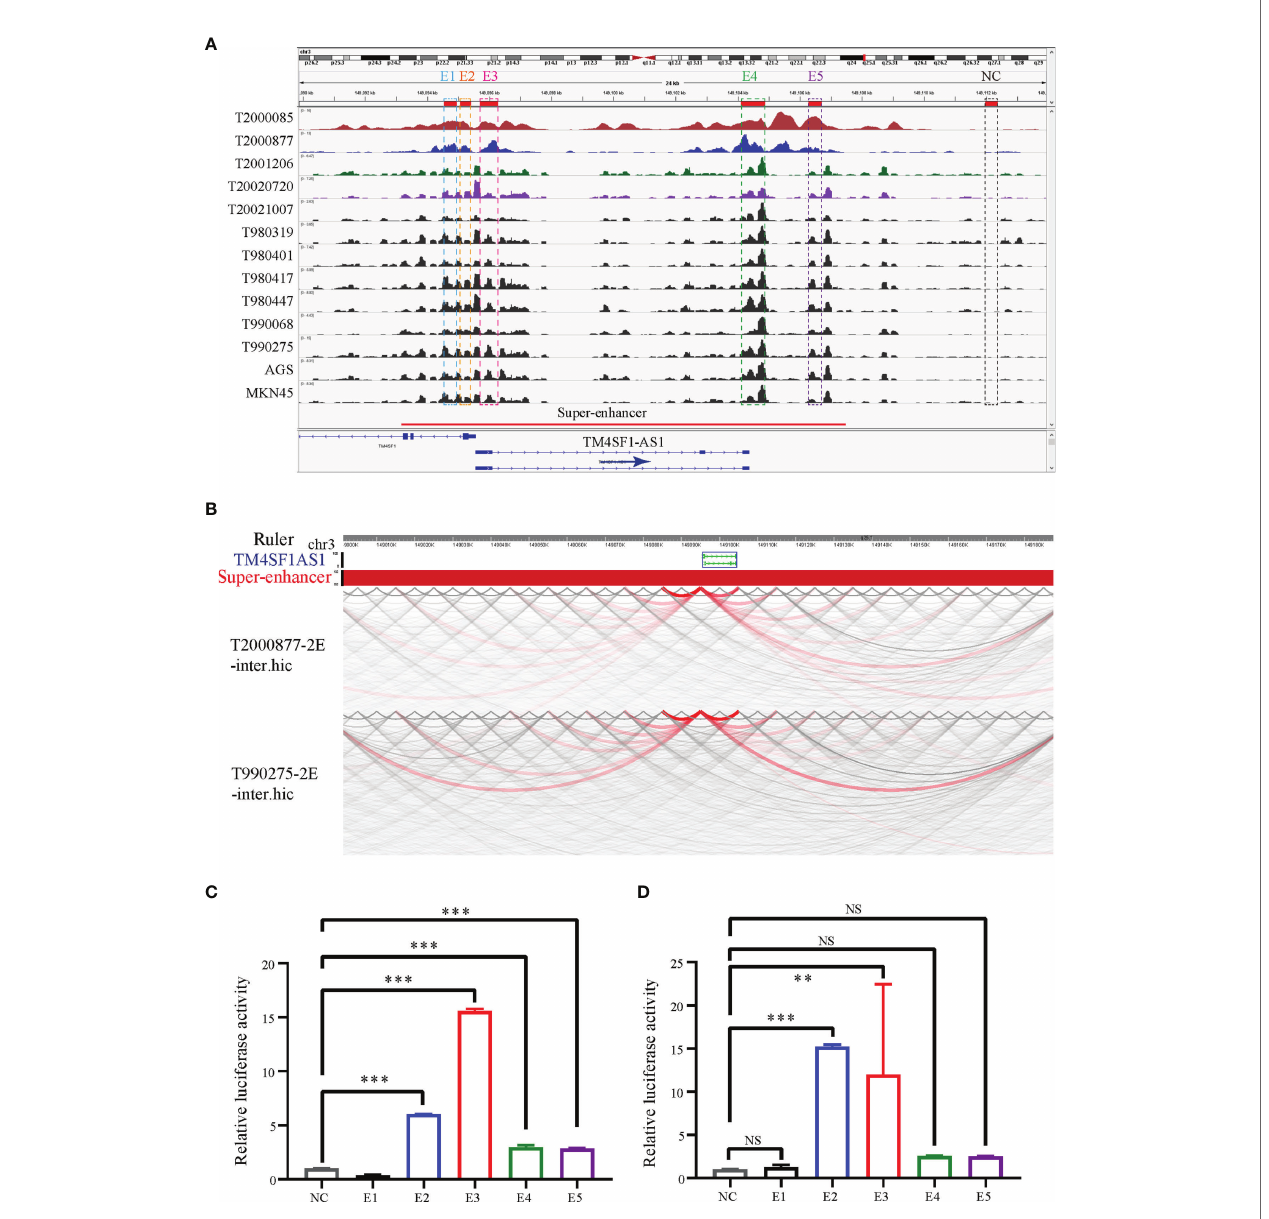
FIGURE 7 | TM4SF1-AS1 is driven by the super-enhancer in STAD. (A) ChIP-seq pro fi les of H3K27ac in 11 STAD samples and 2 STAD cells (AGS and MKN45). The super-enhancer region is divided into fi ve enhancers, and their location information are showed. ChIP-seq with the H3K27ac antibody in AGS cell lines was from this study, and other H3K27ac ChIP-seq in 11 STAD tissue samples and MKN45 cell lines were downloaded from GEO database (GSE117953; https://www.ncbi. nlm.nih.gov/geo/query/acc.cgi?acc=GSE117953). (B) Hi-C data analysis of super-enhancer regions and promoter of TM4SF1-AS1 in two tumor samples (T980401 and T990275). Hi-C data in two tumor samples (T980401 and T990275) was downloaded from GEO database (GSE118391; https://www.ncbi.nlm.nih.gov/geo/ query/acc.cgi?acc=GSE118391). (C, D) Dual luciferase experiments indicating the fl uorescence intensity of all fi ve enhancers compared with that of the NC group in (C) AGS (D) MKN45 cells. ns, no signi fi cance; **p < 0.01, ***p <